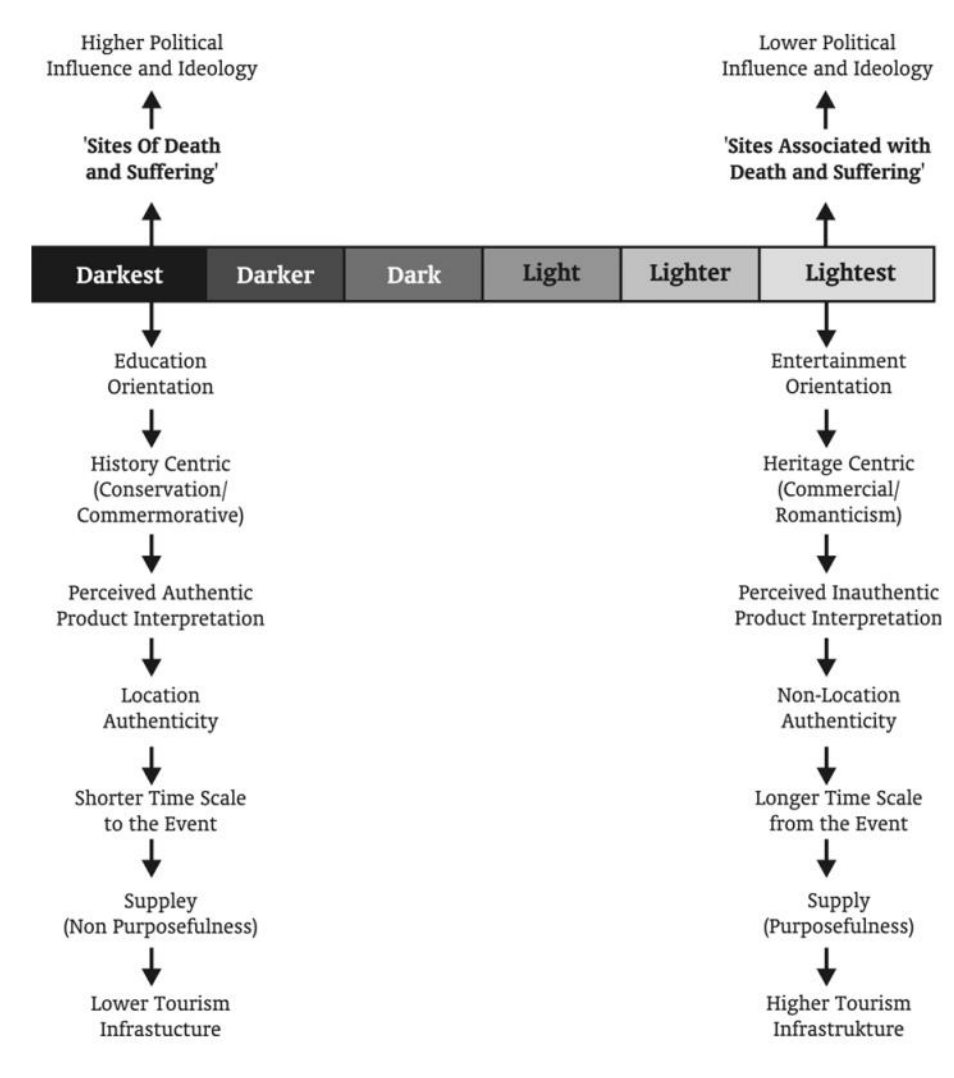
Figure 7. The Spectrum of Dark tourism . Source: (Stone 2006). A Dark Tourism spectrum: towards a typology of death and macabre related tourist sites, attractions and exhibitions. Available online: http://clok.uclan.ac.uk/27720/1/27720%20fulltext_stamped.pdf (accessed on 5 January 2022).